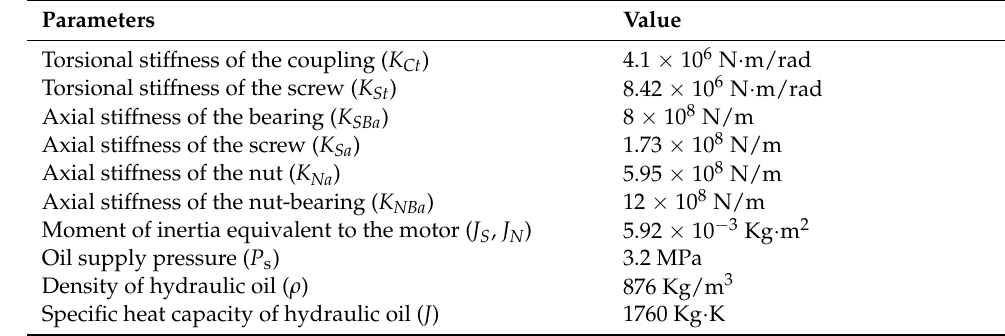
Table 1. Parameters of the feed system.